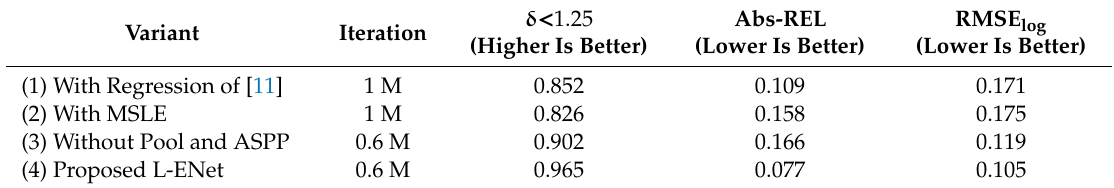
Table 6. Evaluation results with various regression methods on KITTI